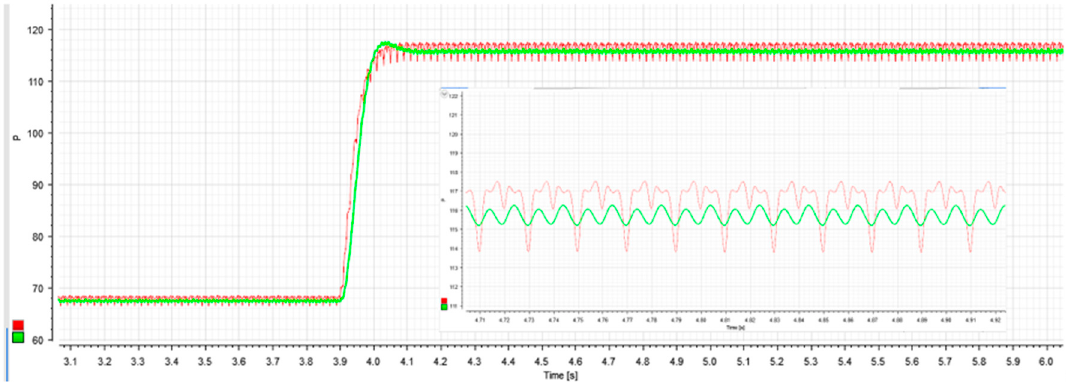
Figure 13. HIL active averaged power calculation, when an abrupt load change occurs, through HIL emulation, using a dSPACE-RTI setup at Aalborg Microgrid Laboratory: active power calculation, Pav (green), PavM (red), and its steady-state ripple detail.